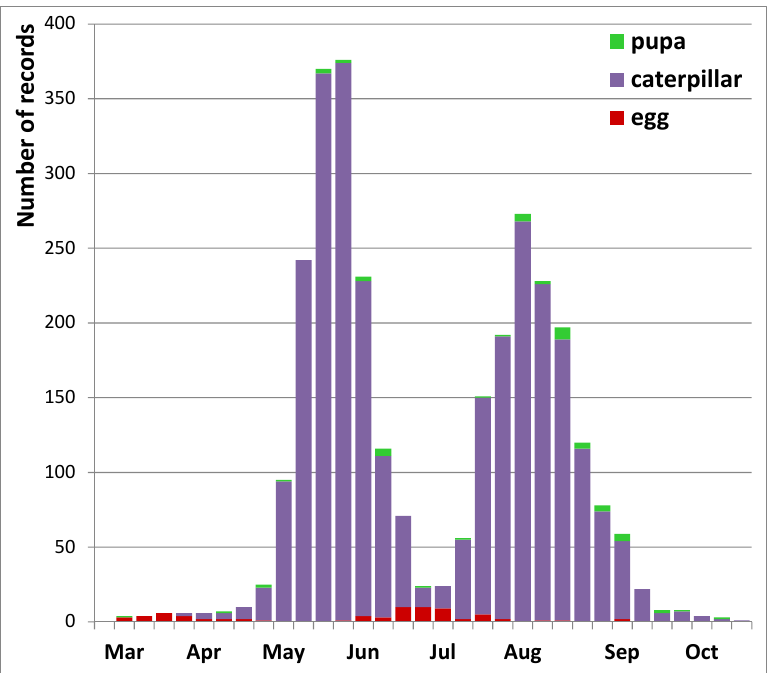
Figure 5. Records of reproduction of peacock butterflies in Belgium 2009–2020 ( n = 3021 records).